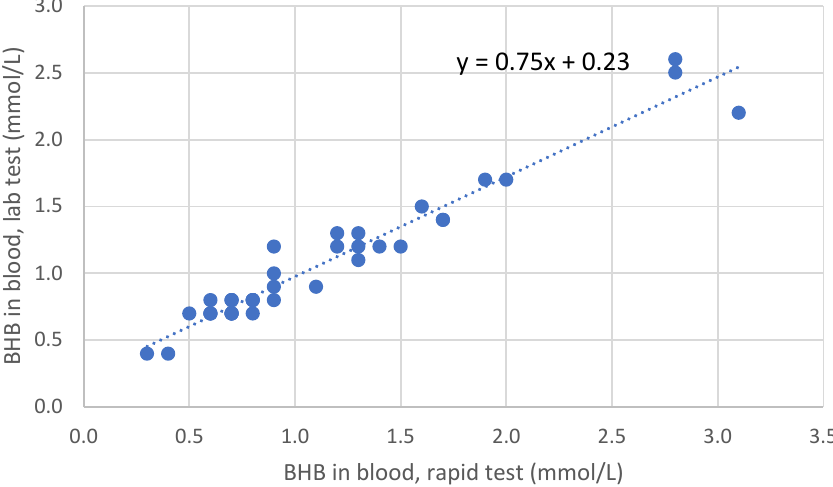
Figure 5. Relationship between blood BHB analysed with a rapid test or in the laboratory ( p < 0.001).